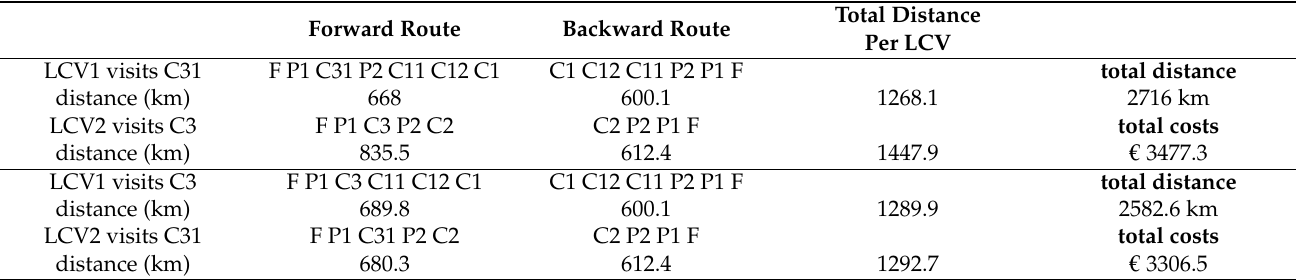
Table 2. The shortest routes for the